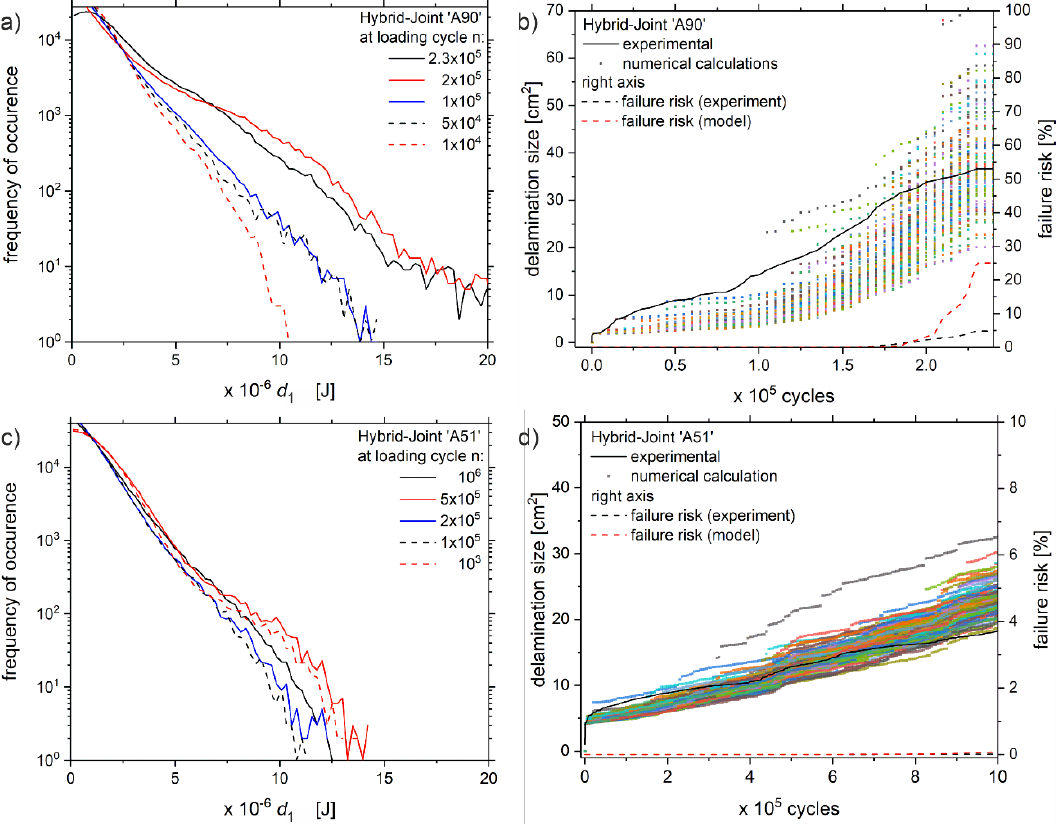
Figure 11. Distribution of dissipation values d 1 for samples ( a ) ‘A90’ and ( c ) ‘A51’ at five different measuring times n, with the corresponding evolution of delamination size during the experiments of ( b ) ‘A90’ and ( d ) ‘A51’, including experimental data (solid line), probabilistic calculated defect size (colored dots) and the resulting failure risk (dashed lines, referring to right axis).